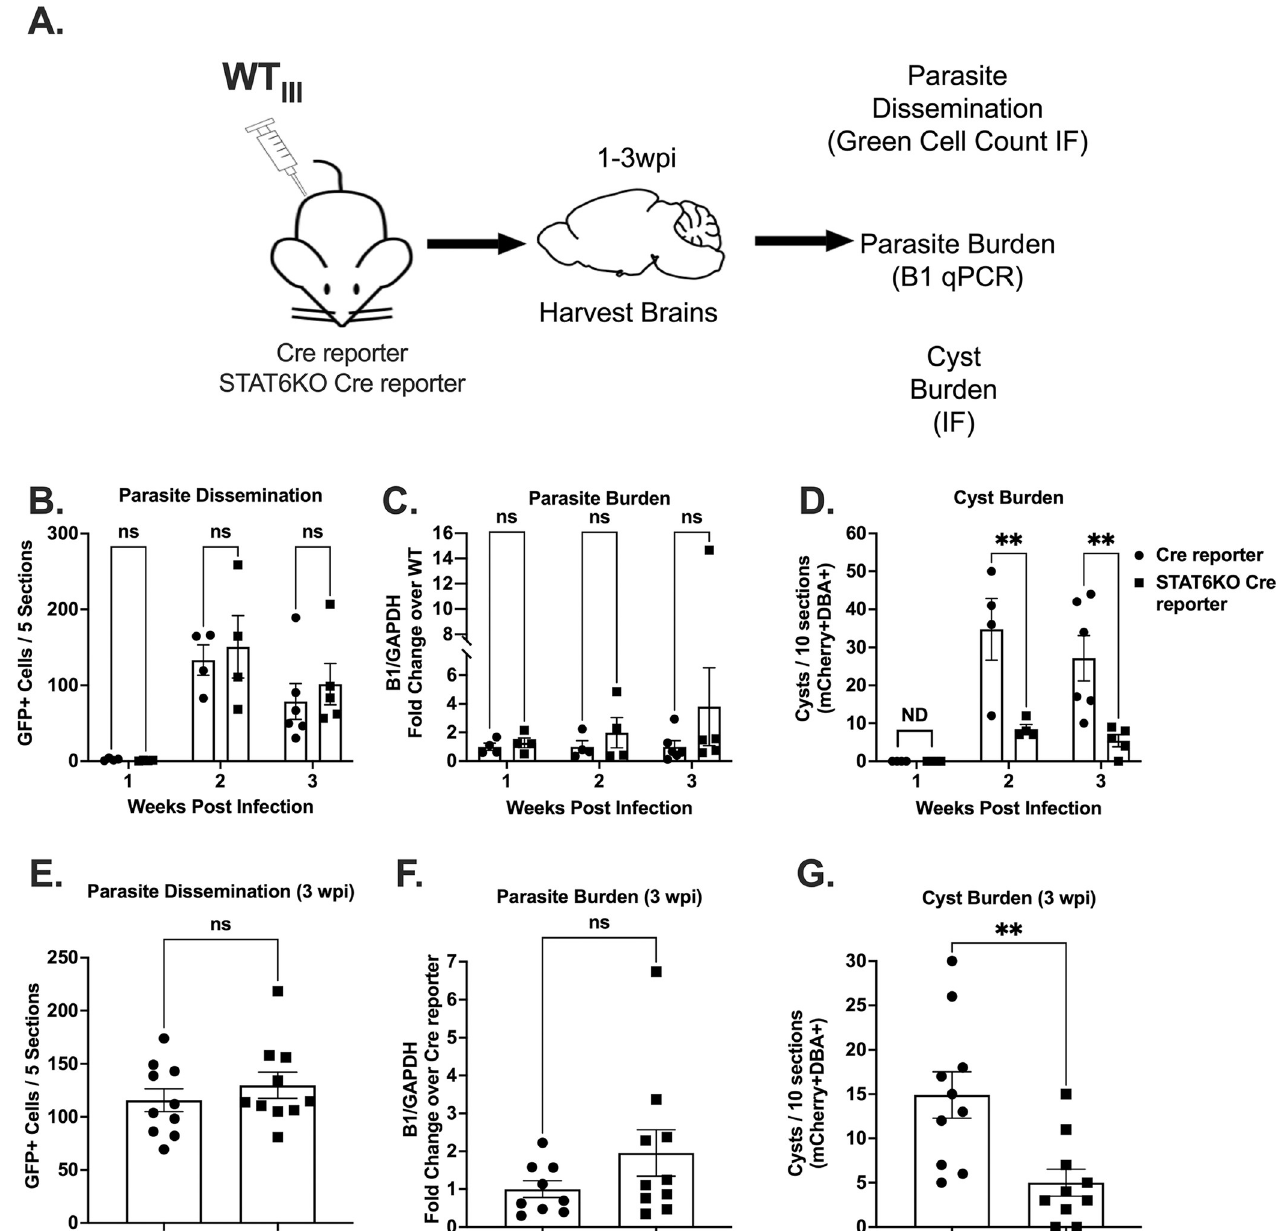
Quantification of T . gondii gene B1 as in ( Fig 5B ). (D) Quantification of cyst burden as in ( Fig 5C ). (E) Quantification of the total number of GFP + cells per 5 sections per mouse. (F) Quantification of T . gondii gene B1 as in ( Fig 5B ). (G) Quantification of cyst burden as in ( Fig 5C ). (B-G) Bars, mean ± SEM. Black dots = 1 mouse. ** p � 0.005, ns = not significant, two-way ANOVA, Dunnett’s multiple comparisons test compared to Cre-reporter. (B-D) N = 4–6 mice per condition per timepoint. (E-G) N = 9–10 mice per